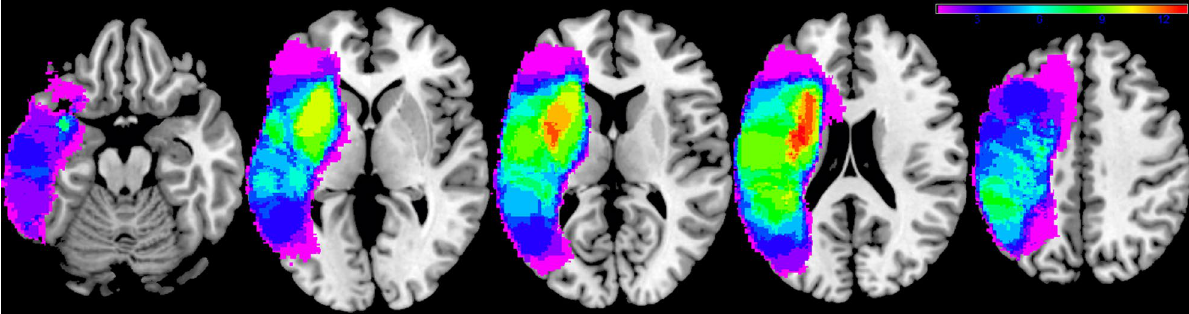
Figure 1. Lesion overlap map. Lesion overlap map for the 17 participant post-stroke aphasia subgroup in MNI space and in neurological convention. Colour bar represents overlap number between 1 and single time interval discrimination (R1); isochrony deviation detection (R2); metrical pattern discrimination (R3); and Dynamic Modulation (DM) detection. P2 and P3 required a same-different choice at a fixed difficulty level, whereas the other tests (P1, R1, R2, R3, DM) used a two-alternative forced-choice adaptive paradigm with a two-down, one-up algorithm that estimated the 70.9% correct point of the psychometric function 32 . Of note, single time interval discrimination is taken to be a measure of rhythm processing in this study. At the start of each test, instructions were explained in a way that was understandable for the participant, and practice trials with feedback were performed to ensure that the participant understood the task and could perform reliably at the easiest difficulty level. Certain tasks using the adaptive difficulty paradigm were frequently too difficult for PSA participants to perform the default starting difficulty used in controls; PSA participants were therefore started at an easier level on these tasks. Due to the large number of trials performed (> 50), all partici- pants reached a stable performance plateau by the end of each test. A basic description of the psychoacoustic tasks are provided below, but a more detailed description was published previously 11 . All three pitch tasks (P1–P3) used pure tones of 250 ms duration and a 2000 ms interval between stimuli on each trial. In P1, two pairs of pure tones were presented on each trial. The participant had to indicate whether the first or the second pair had a change in frequency (either up or down). The size of the change in frequency was adaptively reduced and the threshold, in semitones, was used as the outcome measure. The task comprised of 50 trials. In P2 and P3, two sequences of four tones were played on each trial. Tones within each sequence had vary- ing pitch; participants had to indicate whether the first and second sequences were the same or different to each other. In P2, on the ‘different’ trials, there was one change in frequency in the third or fourth tone that produced a ‘local’ change in pitch without a change in the ‘global’ pattern of ‘ups and downs’. In P3, on the ‘different’ trials, the change in frequency of the third or fourth tone produced a change in the global pitch ‘contour’ of ‘ups and downs’. P2 and P3 each consisted of 40 trials (20 ‘same’ and 20 ‘different). The percentage (score) correct on each task was the outcome measure. All three rhythm tasks (R1-R3) used 500 Hz, 100 ms pure tones. In R1, two tone pairs were played on each trial. Each pair of tones had a slightly different inter-onset interval; the range of inter-onset intervals was 300–600 ms. Participants had to indicate whether the first or the second tone pair had the longer interval. R1 comprised of 50 trials; the difference between the interval of the first and the second pair was adjusted adaptively. The threshold, expressed as the percentage difference between the interval of the shorter and longer tone pair relative to the inter-onset-interval of the shorter pair, was used as the outcome measure. In R2, each trial consisted of two five-tone sequences. One sequence was perfectly isochronous (i.e. had a constant inter-onset interval, with a value between 300 and 600 ms that was varied between trials); the other sequence was not isochronous but had one lengthened inter-onset interval (between the third and fourth tone). Participants had to indicate whether the first or the second sequence contained an ‘extra gap’. R2 comprised of 50 trials; the difference between the lengthened inter-onset interval and the isochronous inter-onset interval was adaptively adjusted. The threshold, expressed as the percentage difference (relative to the otherwise isochronous inter-onset-interval), was used as the outcome measure. In R3, each trial consisted of three seven-tone rhythmic sequences. Each sequence contained seven tones distributed over 16 time units of 180 to 220 ms each, with the unit duration varied between sequences (i.e. within trials). In its correct version the pattern of the sequences featured a strongly metrical beat induced by accented tones occurring every fourth time unit 33 . The first sequence on each trial always had the correct pattern, one of the second or the third sequence on each trial was the same as the first, but the remaining sequence (i.e. the third or the second) had a perturbation in the rhythm that affected the entire pattern and distorted its metricality (for details see 33 ). The participant had to indicate whether the second or the third sequence sounded ‘different’ or ‘wrong’. R3 contained 50 trials; the percentage difference in relative interval timing was adaptively adjusted and the threshold, expressed as the percentage of perturbation relative to the correct pattern, used as the outcome measure as described in 33 .